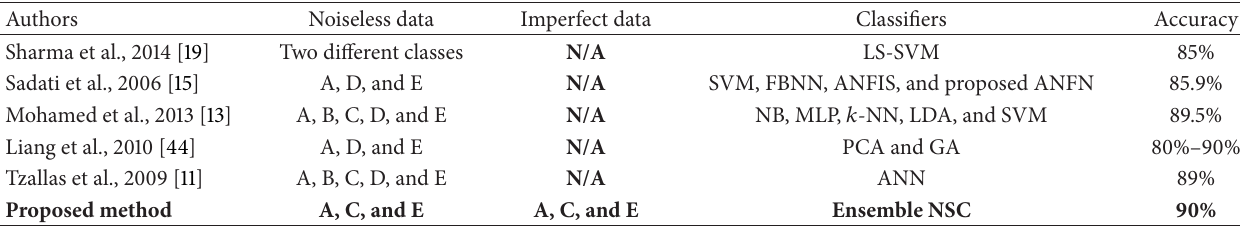
Table 7: Comparisons between previous works and the proposed